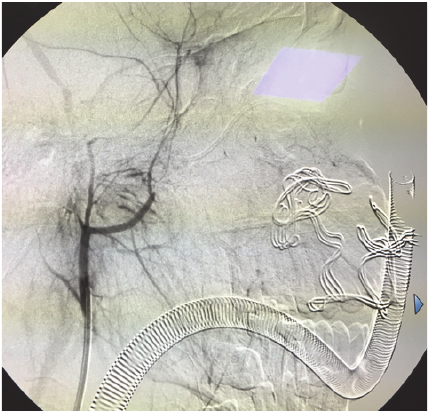
Figure 5: The complete exclusion of the pathological portion of the branch with the pseudoaneurysm is documented.